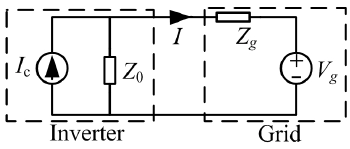
Figure 14. Small-signal representation of inverter-grid system.